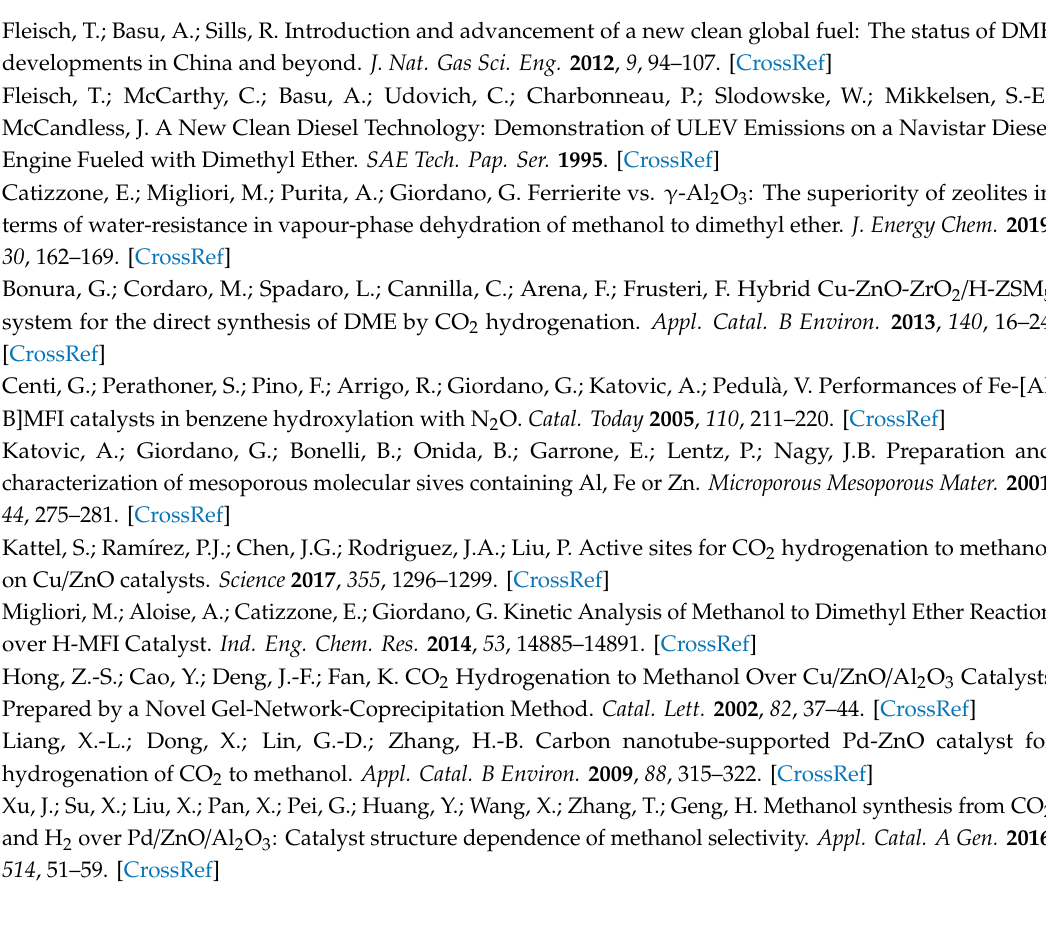
Figure S1: XRD patterns for the parent and hybrid samples. The main metallic phases detected are: metallic copper ( + ), cuprite (*), tenorite (#) and zincite (§); Figure S2: Nitrogen adsorption (closed symbols) and desorption (open symbols) isotherms at 77K for hybrid samples; Figure S3: Pore size distribution for hybrid samples; Figure S4: NH3-TPD data and deconvolution curves for all the investigated